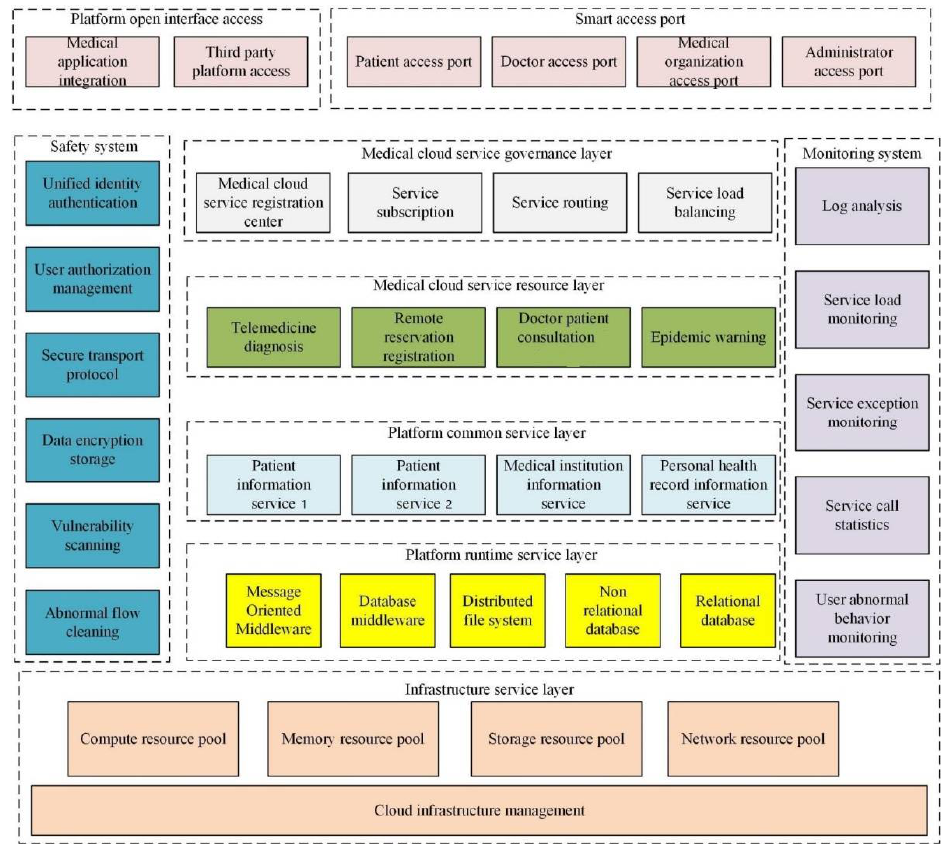
Figure 1. The architecture of the system platform of smart medical cloud service (drawn from research analysis after reviewing the data).